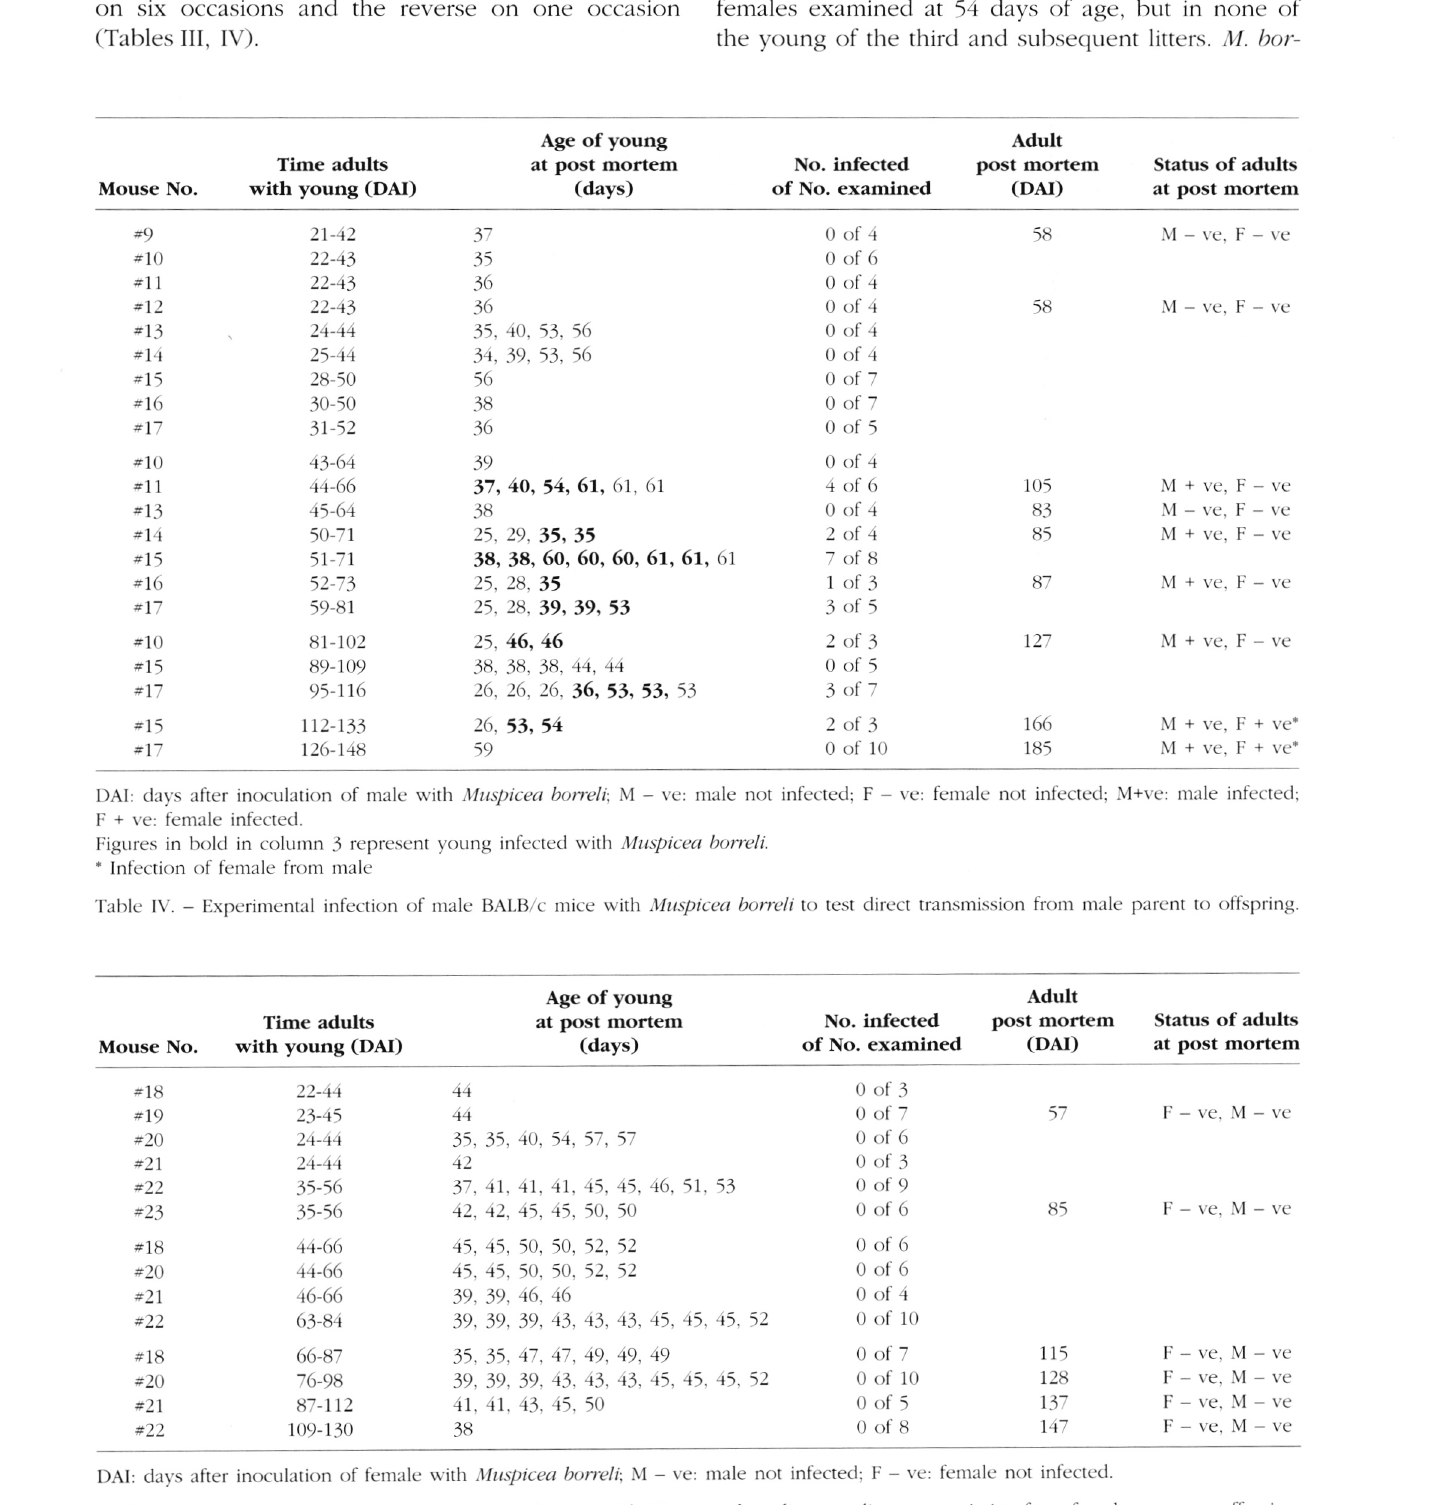
Table V. - Experimental infection of female BALB/c mice with Muspicea borreli to test direct transmission from female parent to offspring. Parasite, 2002, 9,